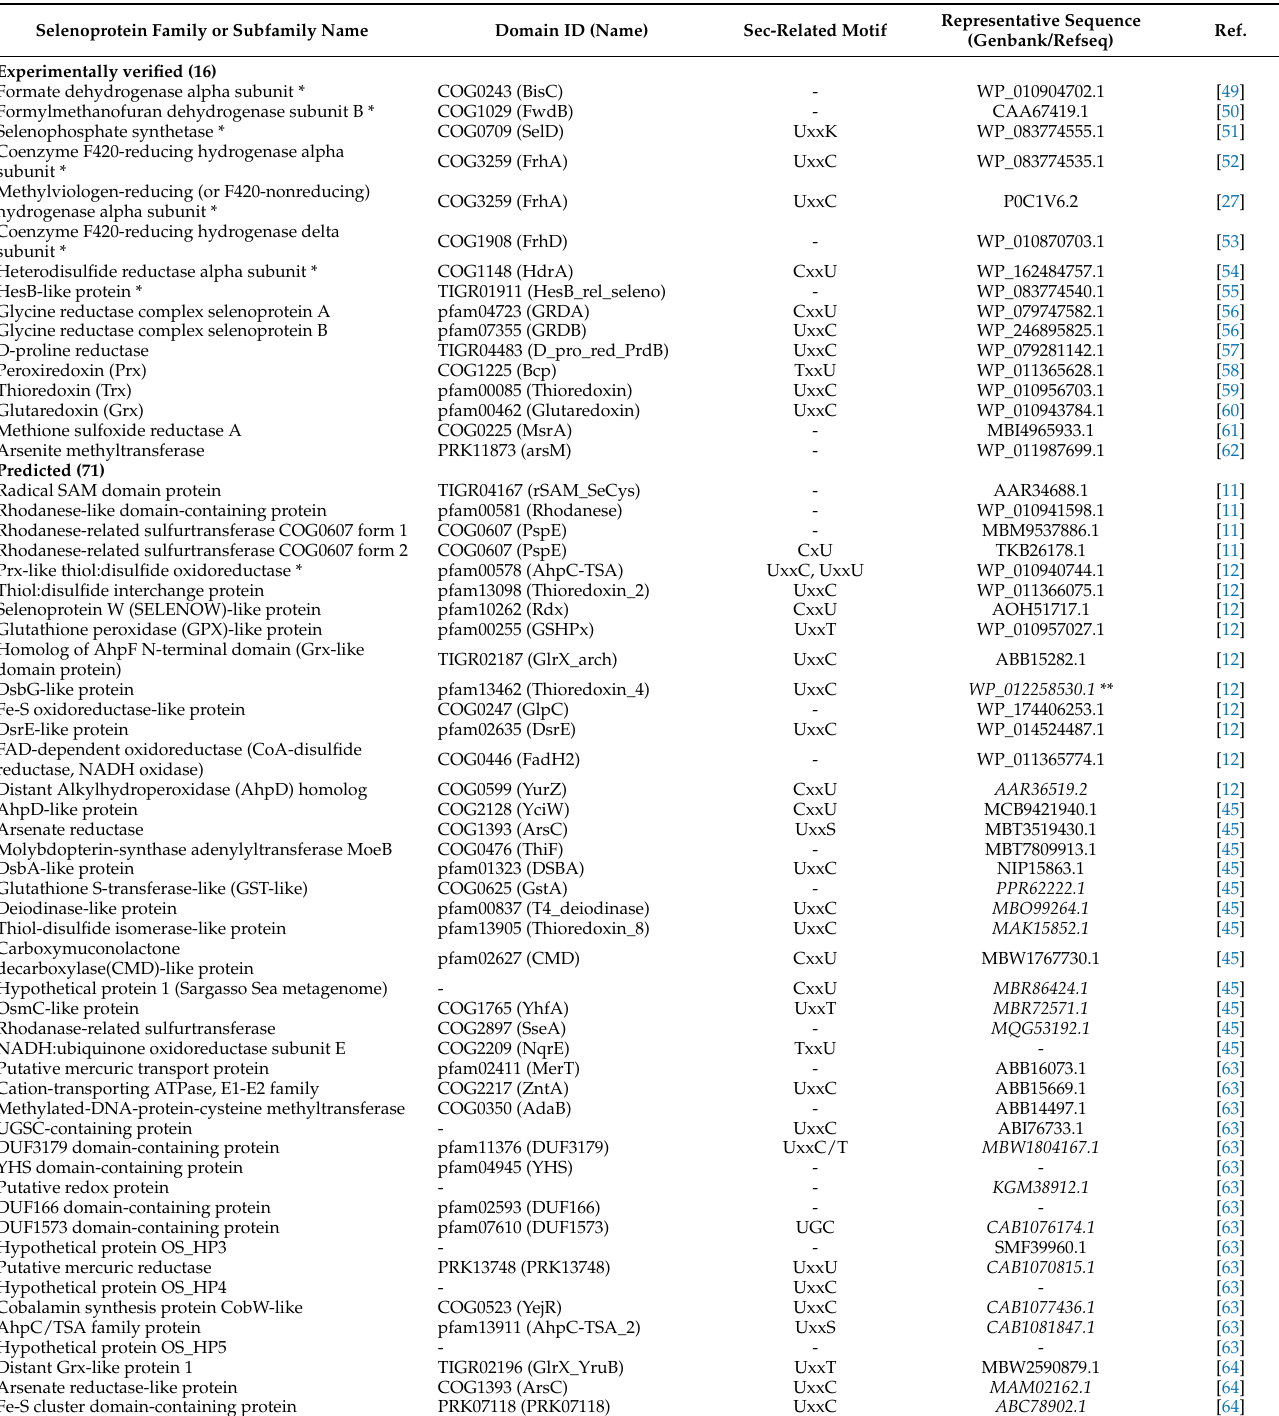
Table 1. A complete list of currently reported selenoprotein families/subfamilies in